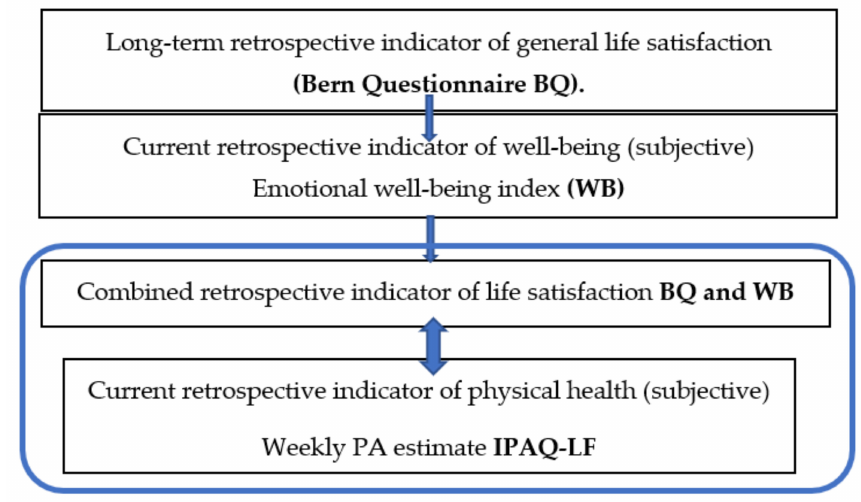
Figure 1. Research